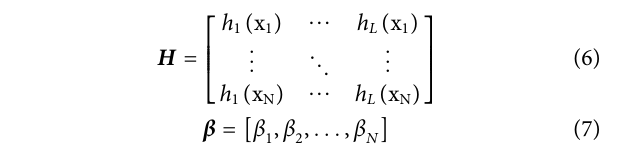
FIGURE 5 | Schematic diagram of kernel extreme learning